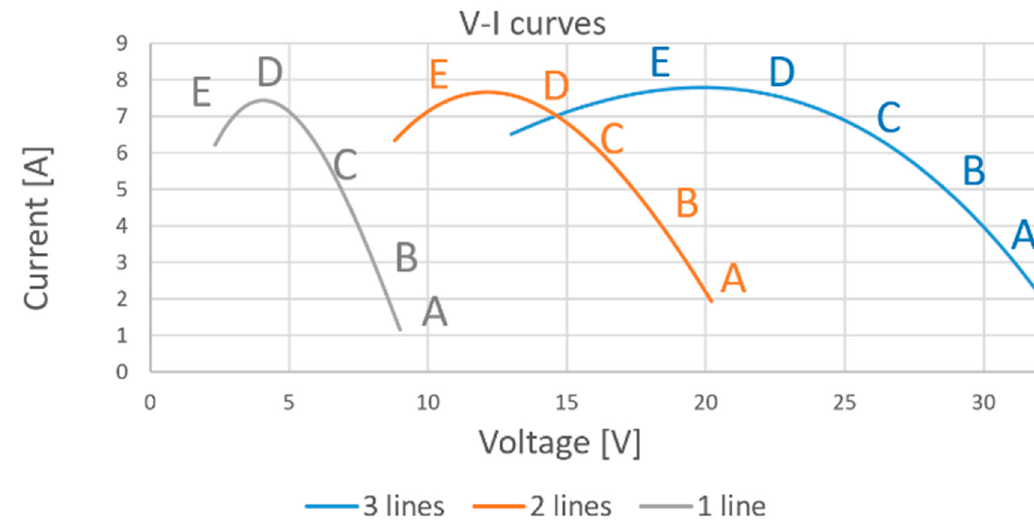
Figure9. InterpolatedV-Icurvesofthepanelwithdi ff erentshadows. Figure 9. Interpolated V-I curves of the panel with different shadows. Working lines have been described.